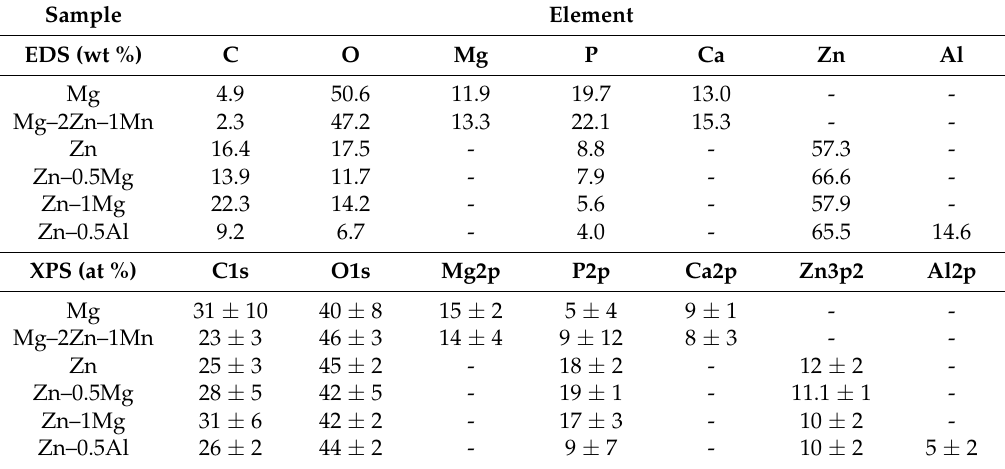
Table 3. Elemental composition of the corrosion layer detected by EDS and XPS. Sample